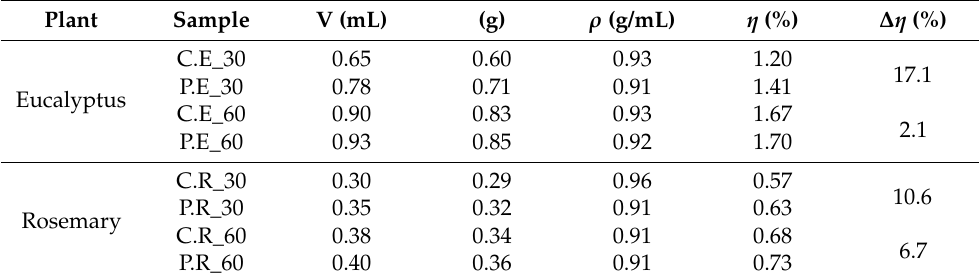
Table 4. Summarized results for the extraction of eucalyptus and rosemary EOs. Plant